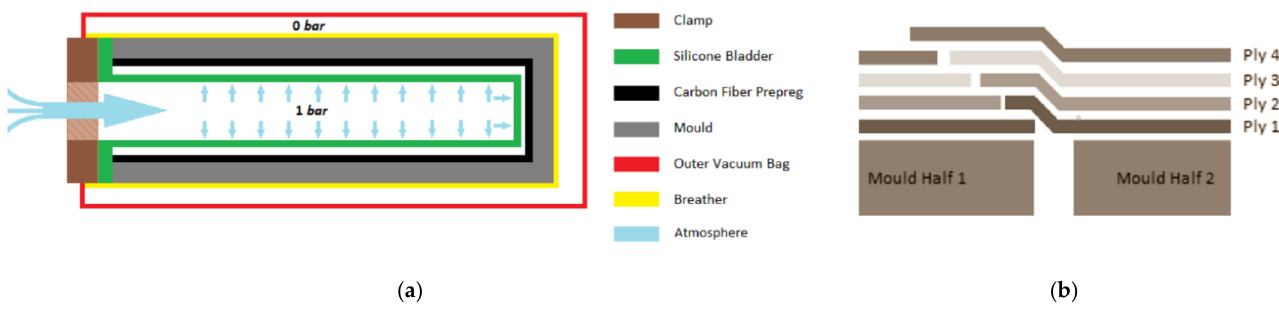
Figure 7. ( a ) Split mould arrangement during casting. ( b ) To the right is an illustration of tapered FRP in the joint of the mould seam shown. Illustrations from [10].